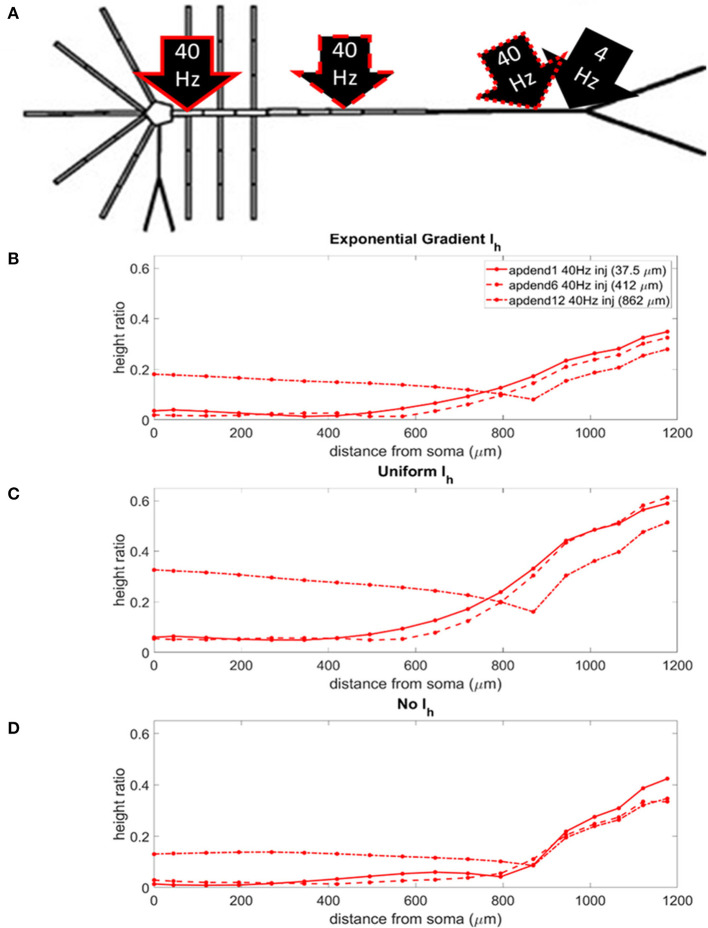
(A) Distal apical dendrite 1.5 nA, 4 Hz modulation (black arrow) with 1.5 nA 40 Hz current injections in base of apical dendrite (black arrow, solid red outline), middle apical dendrite (black arrow, dashed red outline), and distal apical dendrite (black arrow, dot-dashed red outline). (B) Height ratio calculated for the soma, apical dendrite, and apical tuft in the model with exponential gradient in Ih conductance density along apical dendrite. (C) Height ratio calculated for the soma, apical dendrite, and apical tuft in model with uniform Ih conductance density. (D) Height ratio calculated for the soma, apical dendrite, and apical tuft in model with no Ih conductance. Dot symbols along the profiles in (B–D) indicate the distance from the soma of compartments along the soma-apical dendrite axis and apical tuft (measured from the beginning of each compartment).